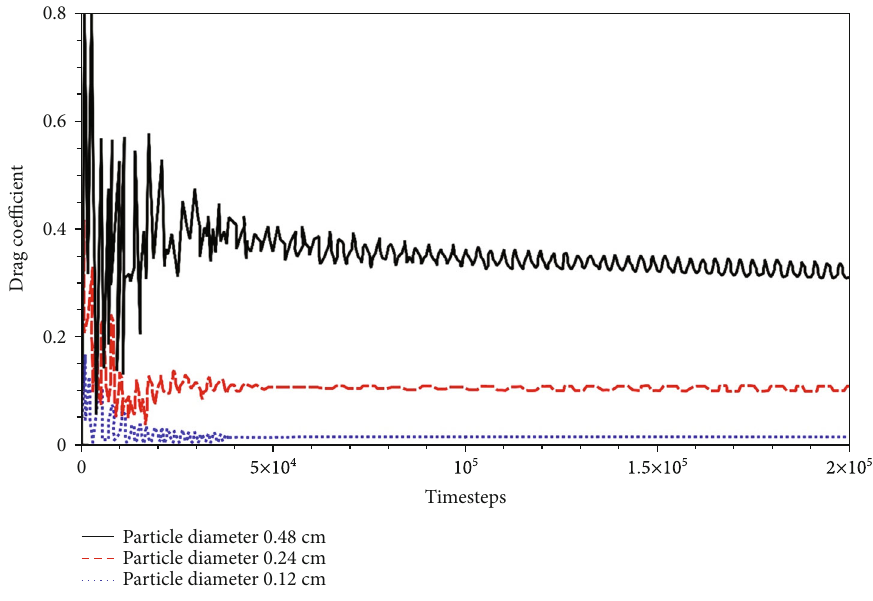
Figure 8: Drag coe ffi cients of circular particles with varying diameters in a corrugated channel. Table 1: Cross-section fl ow and permeability for di ff erent particle